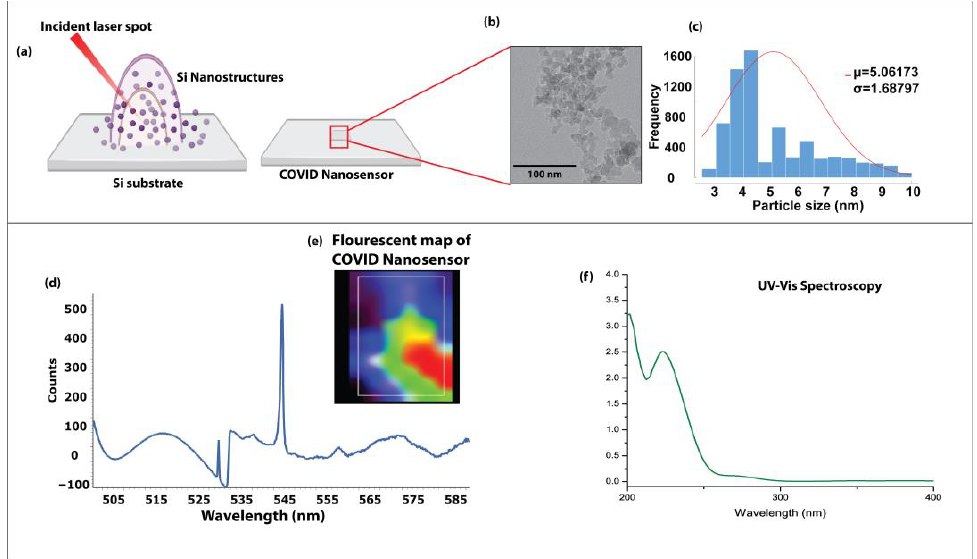
Figure 2. Synthesis and characterization of nanostructured COVID sensor ( a ) Schematic represen- tation of the synthesis of nanostructured COVID sensor using multiphoton ionization process ( b ) Representative TEM image showing the morphology of quantum immunoprobe (Scale 50 nm) ( c ) Histogram showcasing the ultrasmall size of nanostructured COVID sensor based on TEM imaging, ( d ) Optical characterization of nanostructured COVID sensor using fluorescent spectroscopy and UV visible spectroscopy ( e ) Fluorescence mapping of the COVID nanosensor ( f ) UV-Vis spectra of the nanosensor.